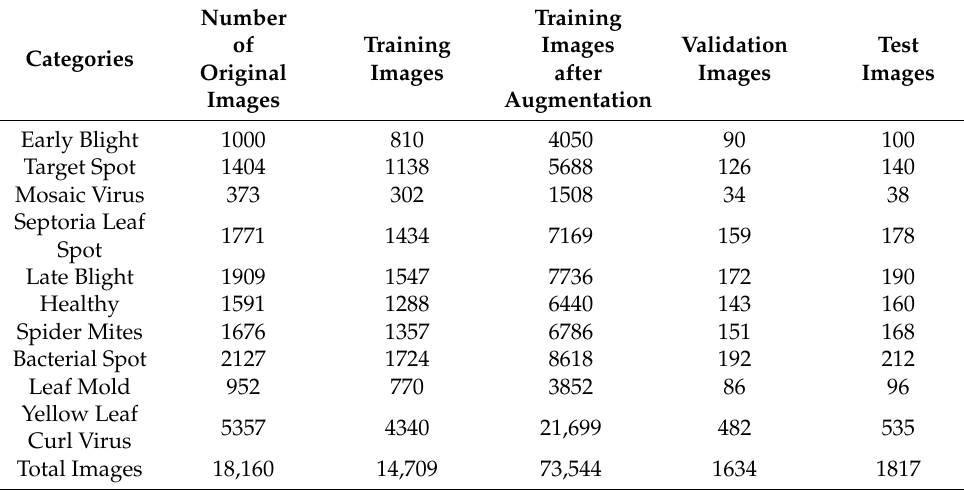
Table 3. Tomato datasets (training, validation, and